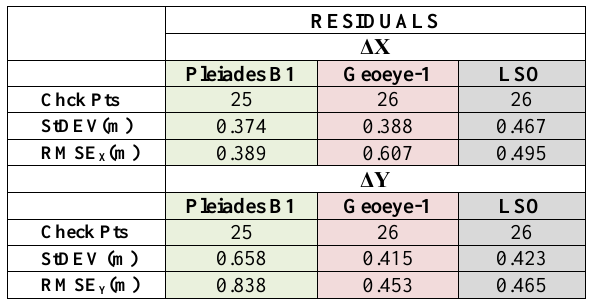
Table 2. Resulting residuals of the measured checkpoints As observed, in aerial imagery LSO and Geoeye-1 orthomosaic, the Standard Deviation and RMSE X,Y differ indicating a systematic error in Y axis. Thus, a bias removal procedure was applied in order to evaluate orthoimages objectively and accurately.